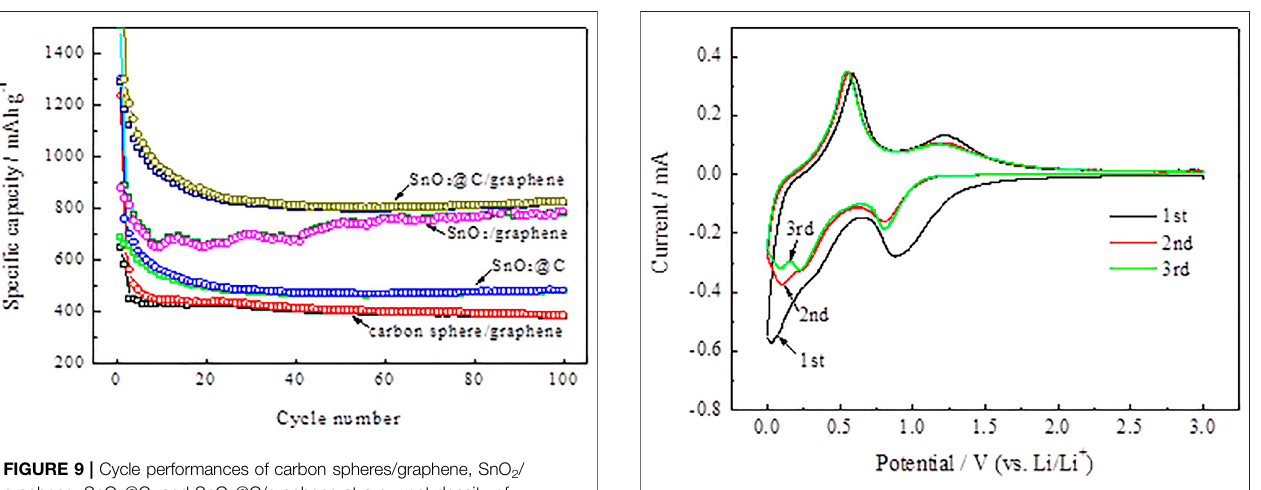
FIGURE 11 | CV curves of SnO 2 @C composite.